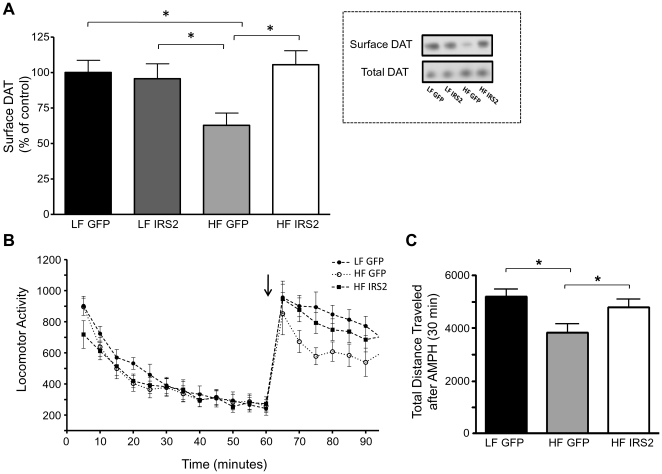
Viral-mediated expression of IRS2 restores surface expression of DAT and AMPH-induced locomotor activity in HF rats.(A) Inset: Representative immunoblots of biotinylated (surface) and total DAT obtained from LF and HF rats injected either with HSV-GFP (LF GFP or HF GFP) or HSV-IRS2 (LF IRS2 or HF IRS2). DAT surface levels were normalized to total and expressed as a percentage of LF, HSV-GFP injected rats (n = 6 per group; *p<0.05 by one-way ANOVA, followed by Bonferroni post hoc test). (B) Locomotor activity measured by beam breaks over time, with AMPH (arrow) given at 60 minutes (1.78 mg/kg, i.p.) to HF rats injected either with HSV-IRS2 (HF IRS2) or HSV-GFP (HF GFP), and LF rats injected with HSV-GFP (LF GFP). (C) Total distance traveled in a 30 min time period after injection of AMPH in HF IRS2, HF GFP and LF GFP injected rats (LF GFP, n = 13; HF GFP, n = 12; HF IRS2, n = 13; *p<0.05 by one-way ANOVA, followed by Newman-Keuls multiple comparison test). Data are represented as mean ± S.E.M.